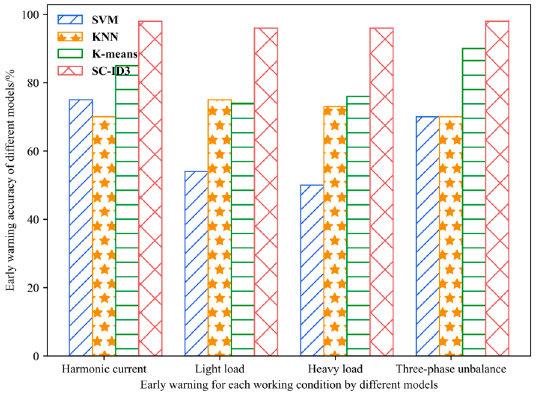
Figure 10. Comparison of multiple model recognition results.